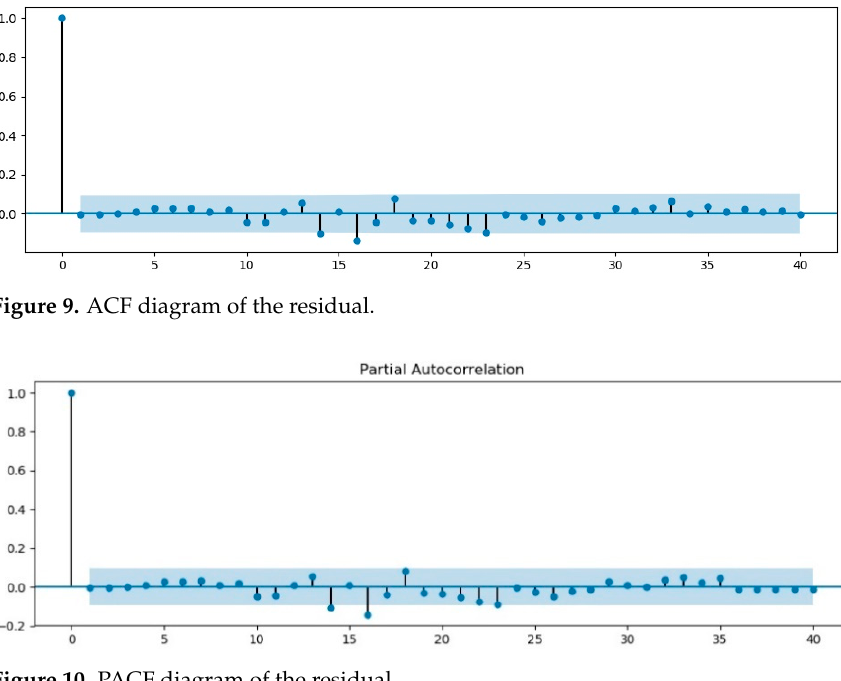
Figure 10. PACF diagram of the residual.